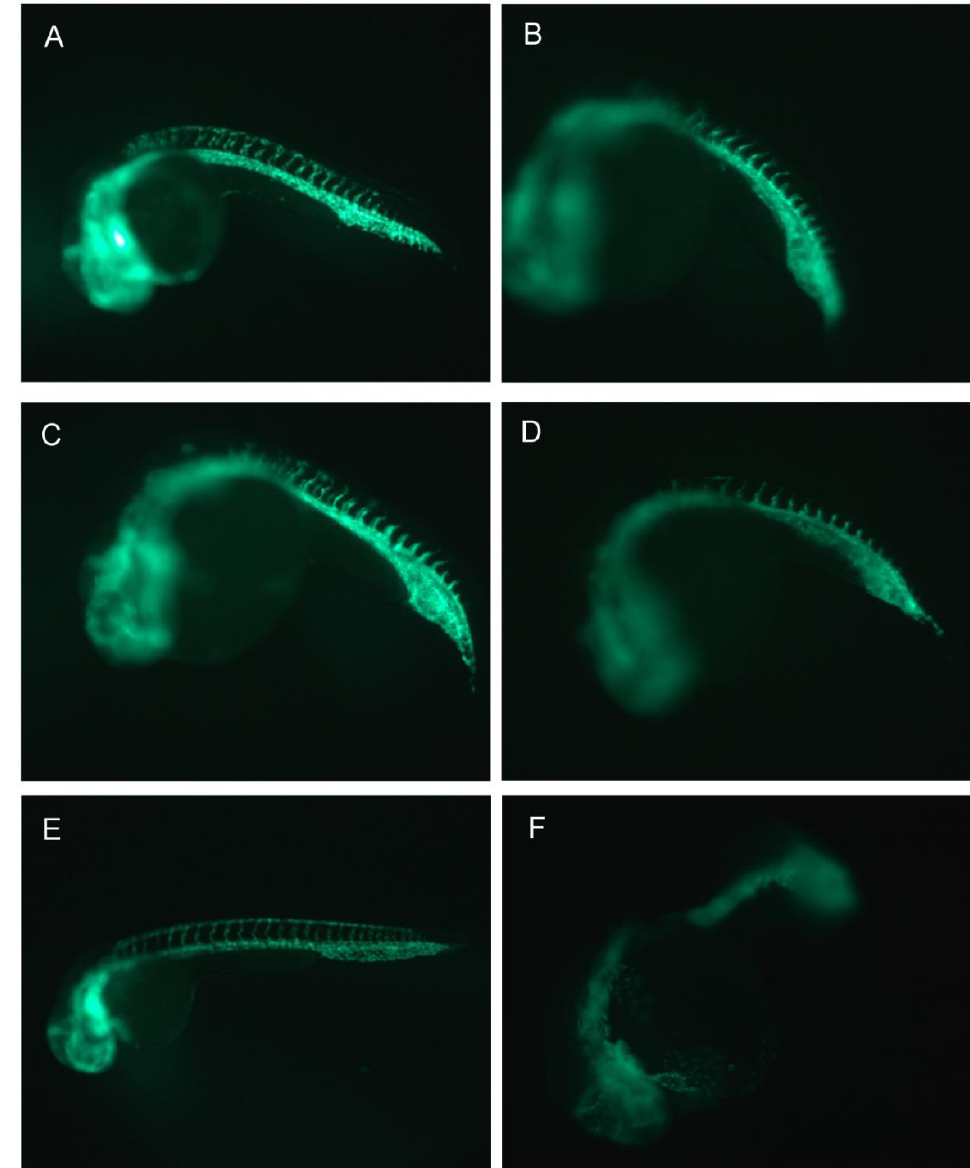
Figure 4. The anti-angiogenic effect observed in Tg(fli1: EGFP) zebrafish embryos exposed 6 hpf ( A – D ) and 12 hpf ( E , F ) to N -[(3-chloro-4-methoxyphenyl)methylidene]-4-methylbenzenesulphonohydrazide at a concentration of 15.81 mg/L (46.67 µ M) vs respective negative controls (6 hpf-( A ), 12 hpf –( E )) (24-h exposure; (( A – D ) 63 × magnification, ( E , F ) 50 × magnification).